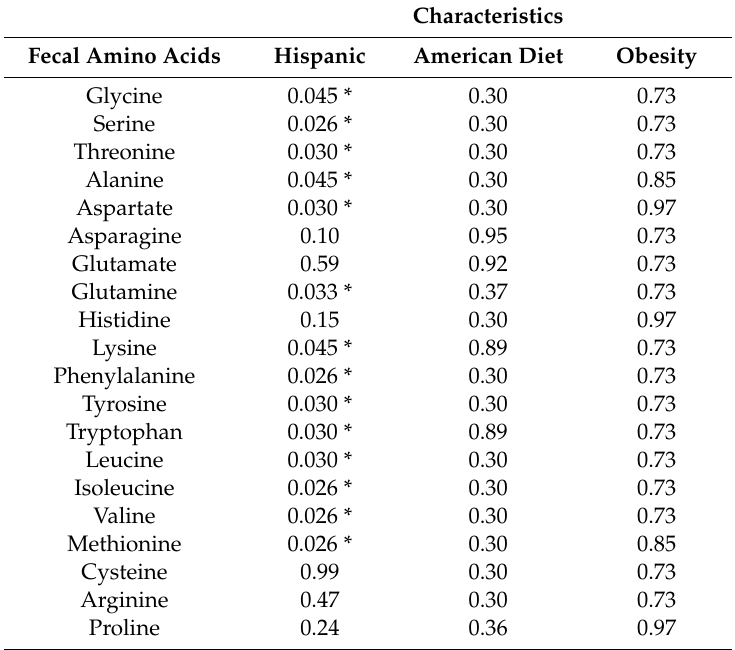
Table 3. Multiple one-way ANOVA q values of characteristics associated with fecal amino acids adjusted for